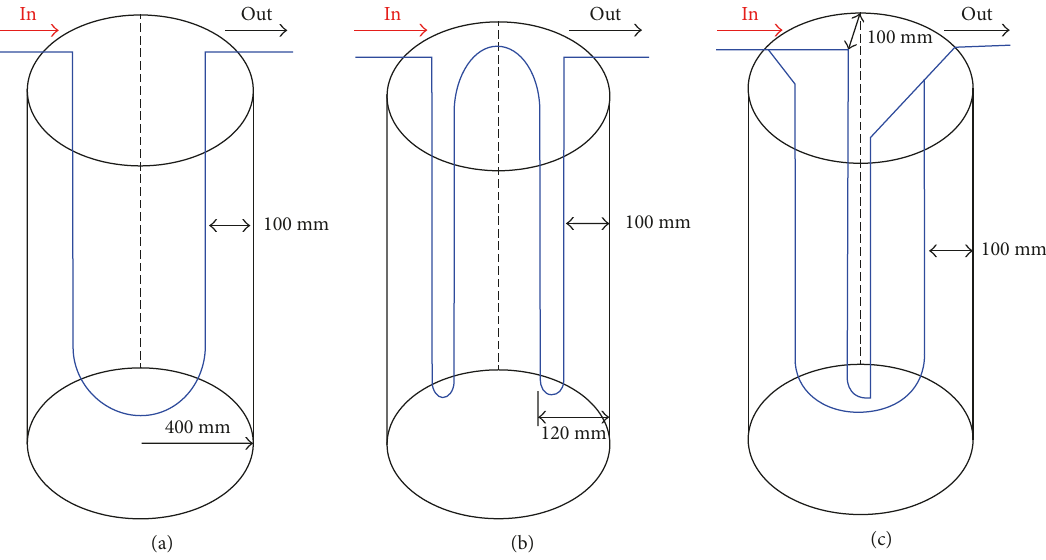
Figure 9: Different pipe configurations cast-in pile. (a) U-shaped. (b) W-shaped. (c) Double U-shaped.